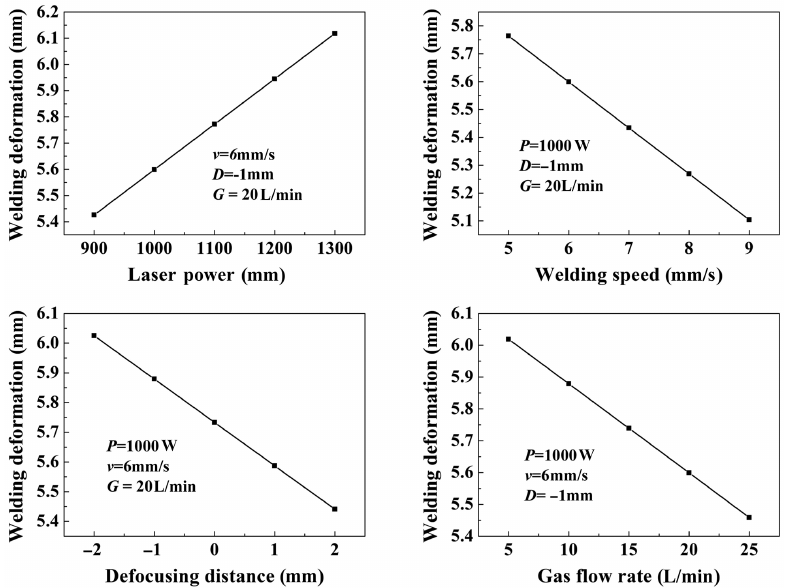
Figure 7: Direct impact of individual factors on